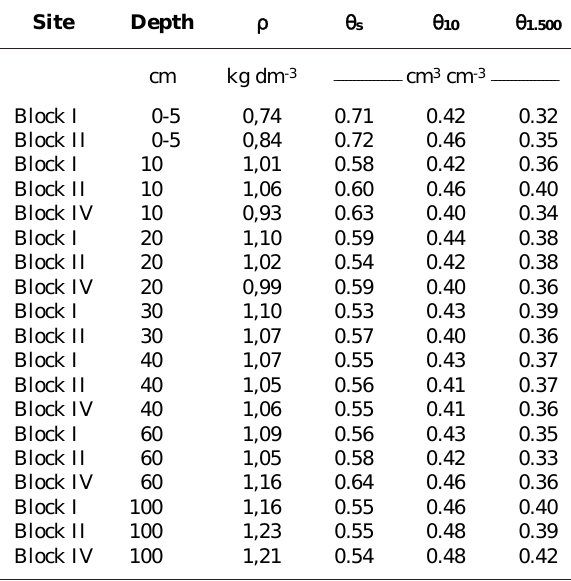
Table 1. Soil bulk density ( ρρρρρ ) and volumetric water content: saturated ( θθθθθ ), submitted to s